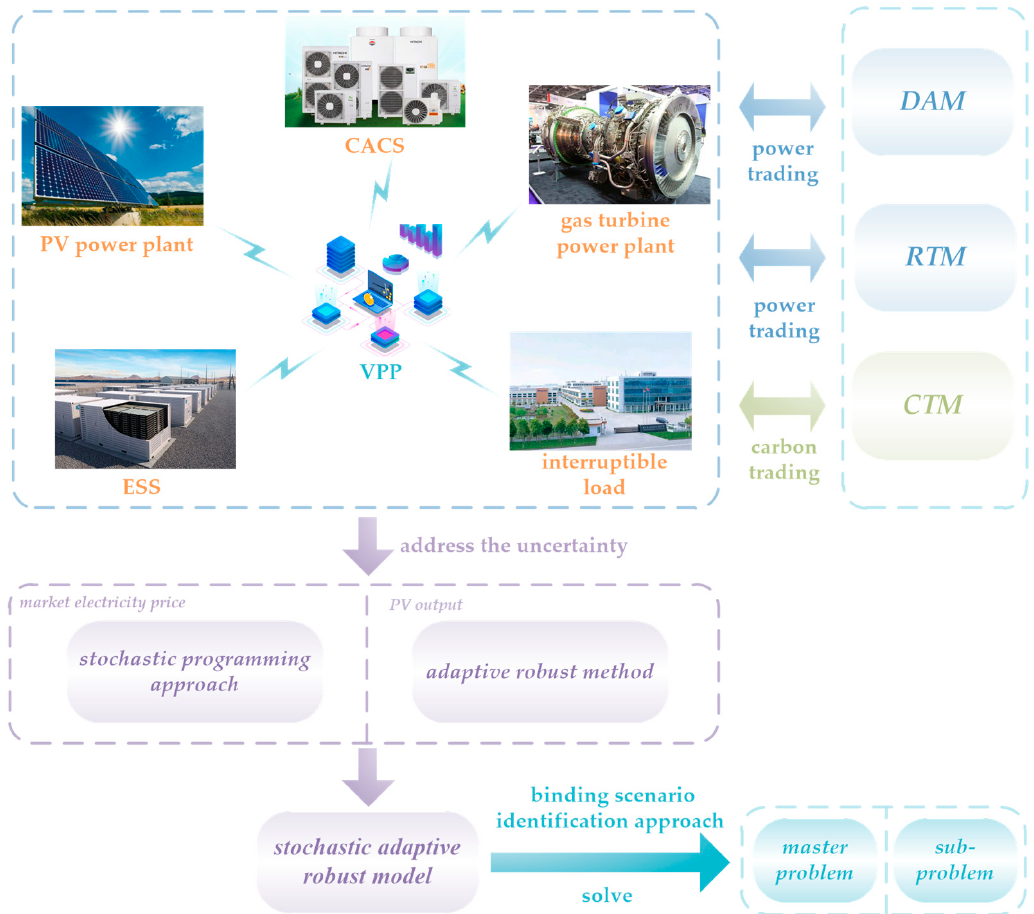
Figure 1. Overall framework of this study.